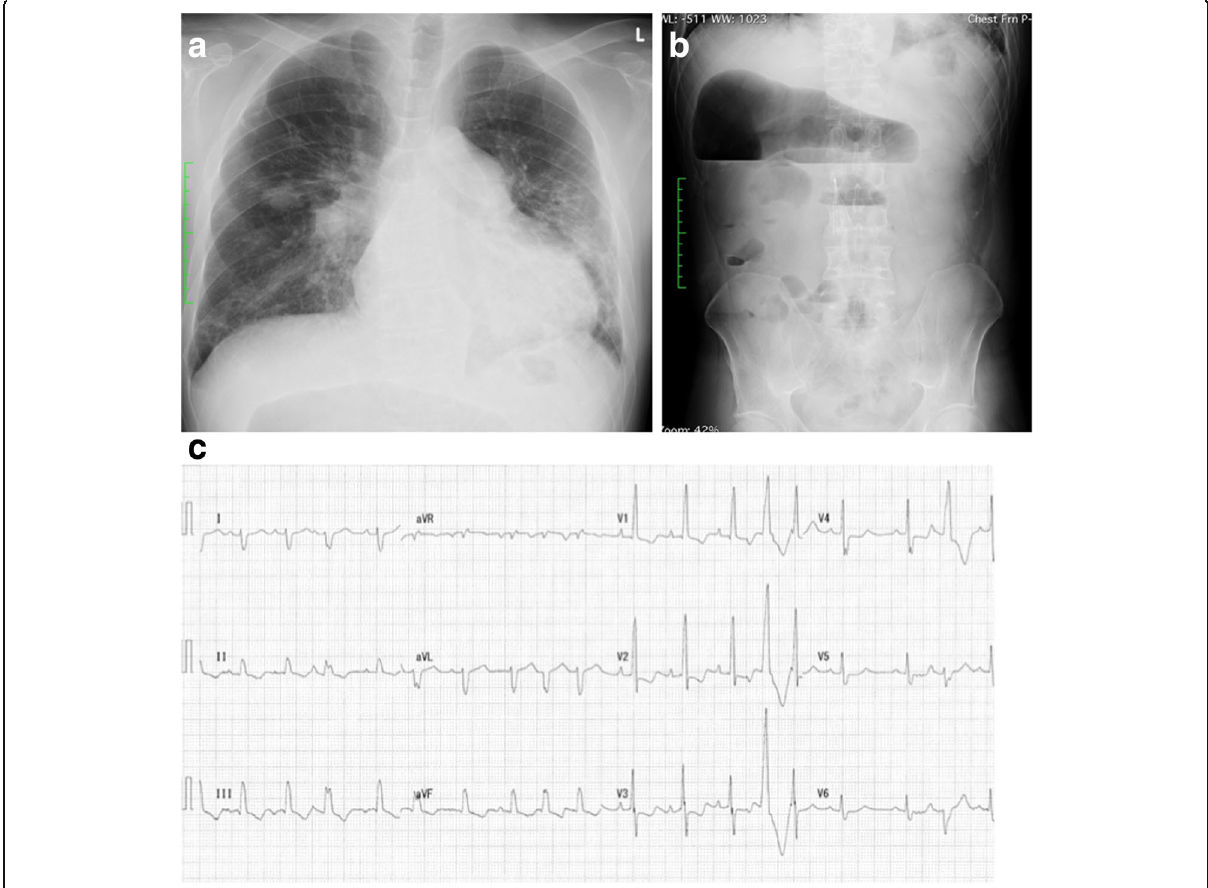
Fig. 1 a Preoperative chest radiograph showing cardiomegaly involving the right cavities and notable enlargement of the pulmonary arch. b Preoperative abdominal radiograph showing chronic intestinal paralysis. c Preoperative electrocardiogram showing a right bundle branch block and right ventricular